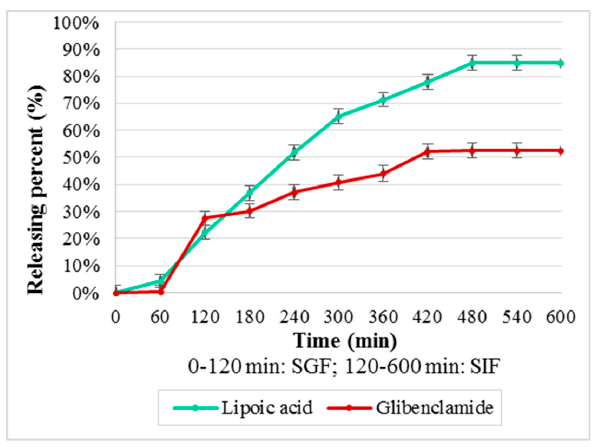
Figure 8. Releasing percent (%) from CS–Gly and CS–LA systems.